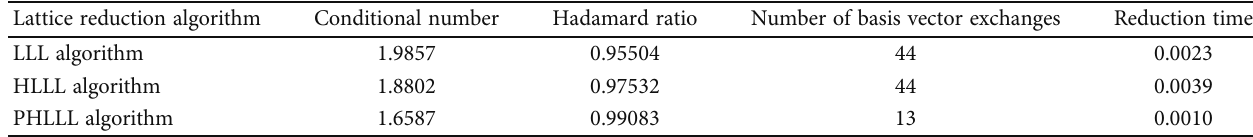
Figure 4: Time comparison of lattice reduction in three cases. Table 1: Comparison of di ff erent algorithm speci fi